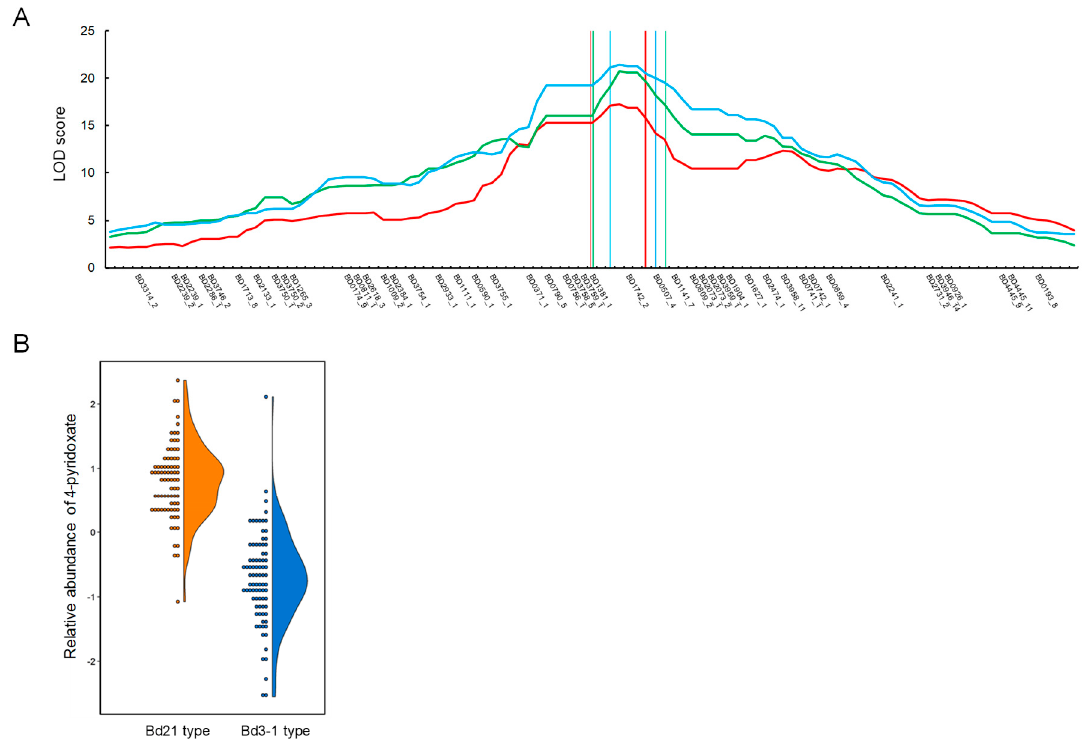
Figure 4. Genetic mapping of QTLs for 4-pyridoxate accumulation in the Bd3-1 × Bd21 RILs. ( A ) A QTL likelihood (LOD) map of the genomic region that covers the QTL region of interest, with a LOD significance threshold of p < 0.05. The colored LOD curves correspond to three replicates of metabolome measurements. ( B ) Average relative abundance of 4-pyridoxate in seeds for the genotypes nearest to the closest marker, BD1742_2, in the RILs.